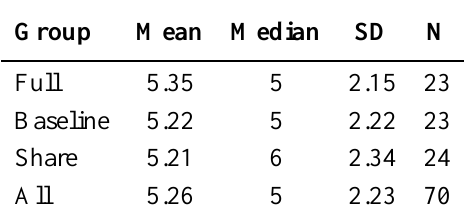
Table 3. Number of safe choices by